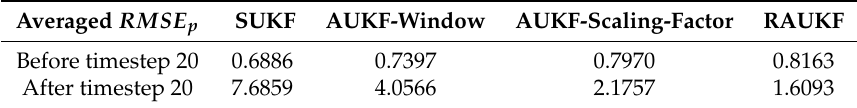
Figure 4. Comparison of RMSE p ( k ) results of different algorithms before and after an abrupt change ( v ) of the Q . k Table 4. Averaged RMSE p before and after timestep